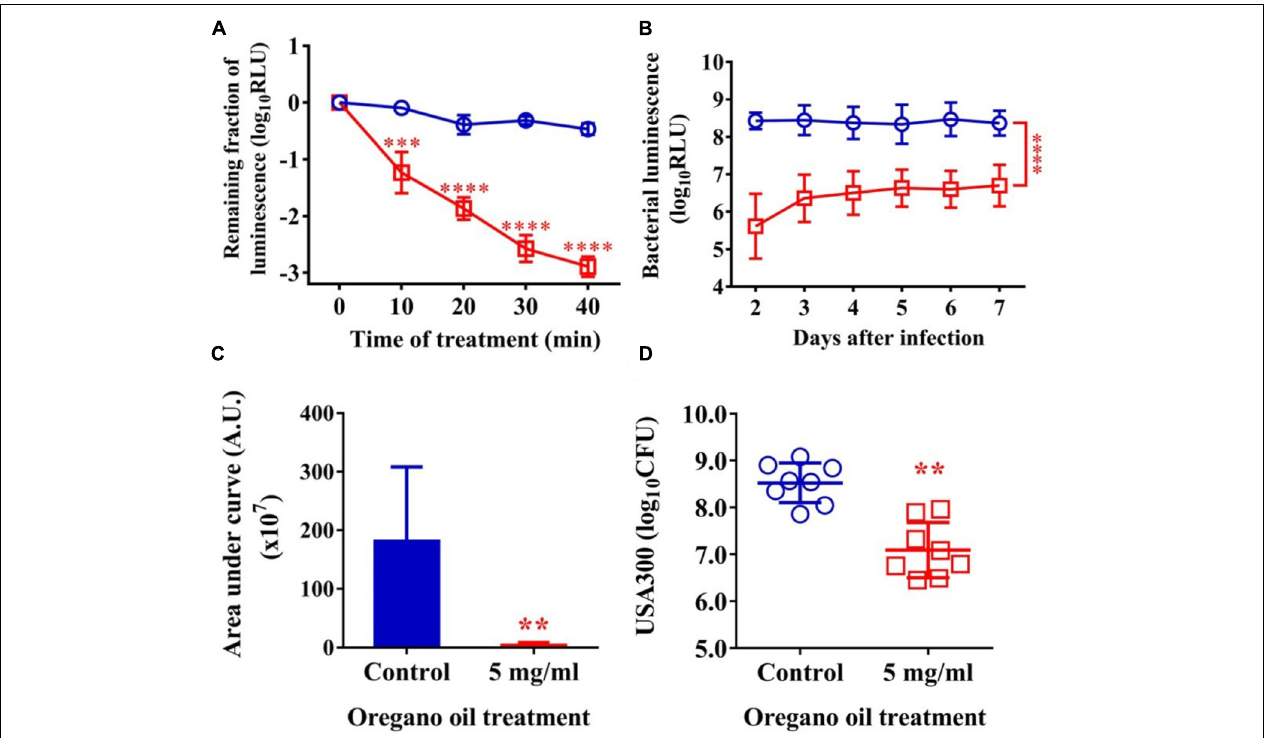
FIGURE 5 | Oregano oil treatment of MRSA USA300 in infected wounds. (A) The change in mean bacterial luminescence of the wounds infected with 5 × 10 6 CFU of USA300 with or without 5 mg/ml oregano oil treatment. (B) Time courses of mean bacterial luminescence of the infected wounds with and without oregano oil treatment. (C) Mean areas under the bacterial luminescence curves in (B) . (D) The wounds were treated with grape seed oil (control) or oregano oil once 24 h after infection and bacterial CFU were quantified on day 7 after bacterial inoculation. The data represent means ± SDs ( n = 8). ∗∗ p < 0.01, ∗∗∗ p < 0.001, and ∗∗∗∗ p < 0.0001 in the presence vs. absence of 5 mg/ml of oregano